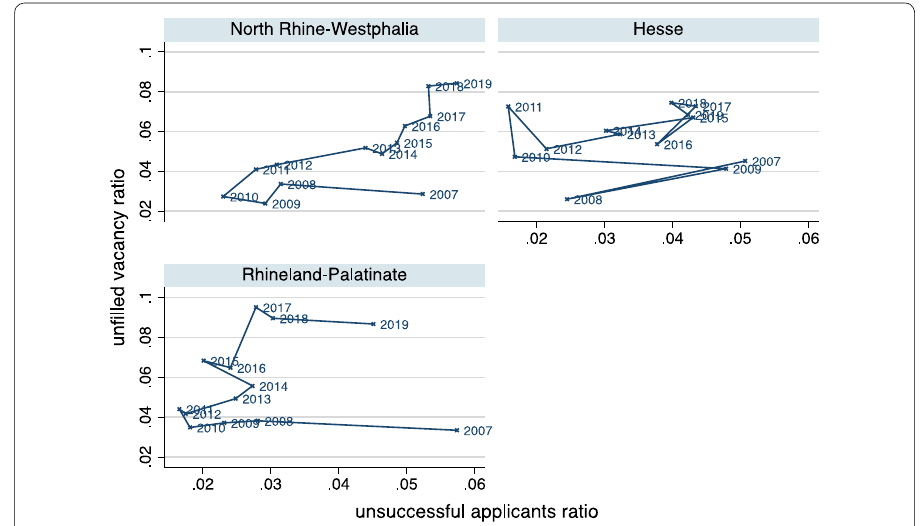
Fig. 9 Beveridge curves for West German states (2007–2019). Data sources: Vocational training statistics of the statistical offices of the federal and state governments